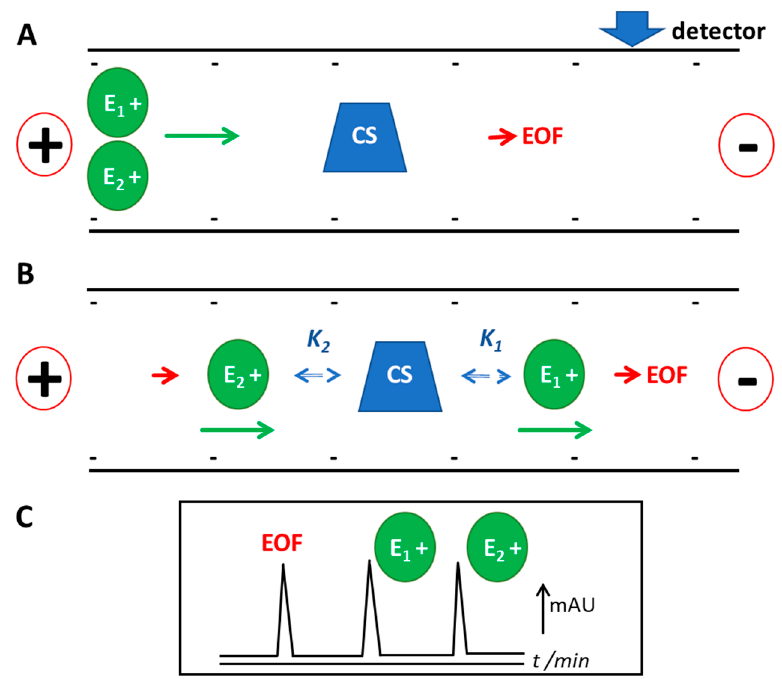
Figure 1. Chiral separation of a positively charged racemate in EKC with a neutral CS as pseudophase. The initial condition is shown in ( A ). The fused silica capillary contains (negative) ionisable silanol groups at the walls. The capillary is filled with background solution (typically a buffer to maintain a certain pH) that contains CS. The sample (containing the two enantiomers) is injected in the inlet or left end of the capillary. A voltage is applied at positive polarity, or negative electrode at the outlet or detector end. The electric field produced drives the separation and detection of the analytes. The direction of EOF and electrophoretic velocity of analytes are to the cathode (right, detector end). The neutral CS migrates in the same velocity as the EOF. The interaction of enantiomer 2 (E 2 ) to the neutral CS is stronger compared to enantiomer 1 (E 1 ), as depicted in ( B ). The binding constant (K) for E 2 is larger compared to E 1 , or K 2 > K 1 . The apparent velocity of E 2 (in the direction of the cathode) is slower than E 1 . E 1 is thus detected earlier than E 2 , as shown in the drawn electrochromatogram in ( C ). The EOF (with a neutral probe) is detected after the positively charged enantiomers. The difference in apparent velocity due to the differential interaction of the enantiomers with the pseudophase causes the chiral separation.